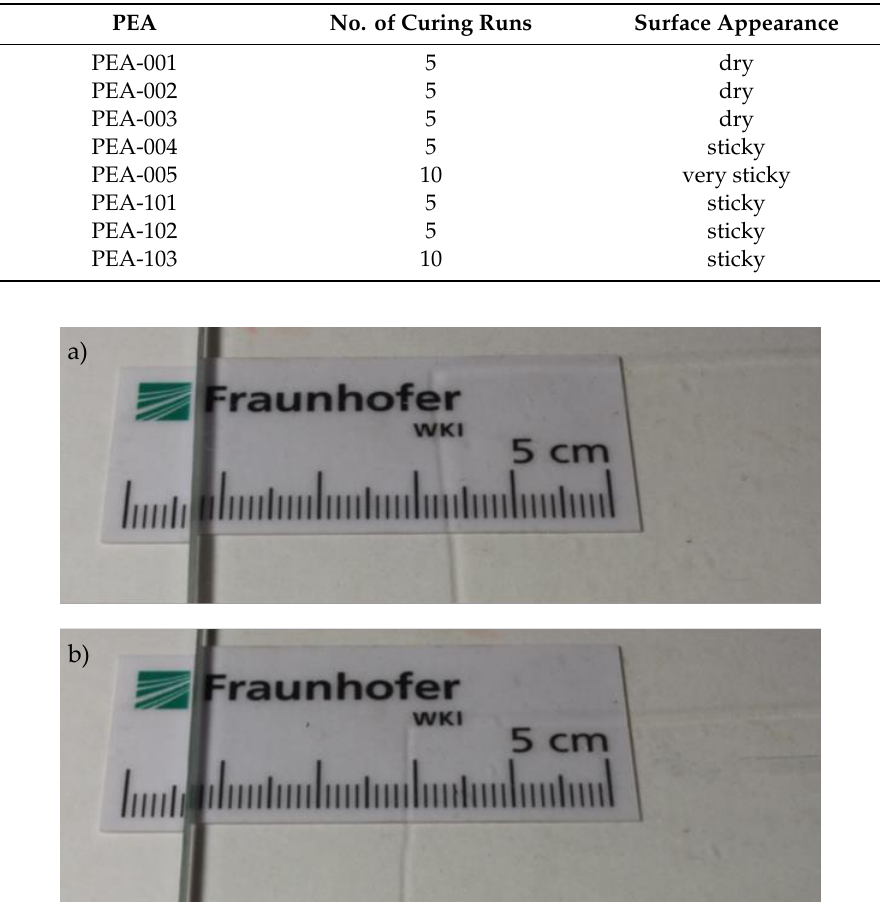
Figure 7. Pictures of the films obtained after UV-curing. ( a ) PEA-001 and ( b ) PEA-003.